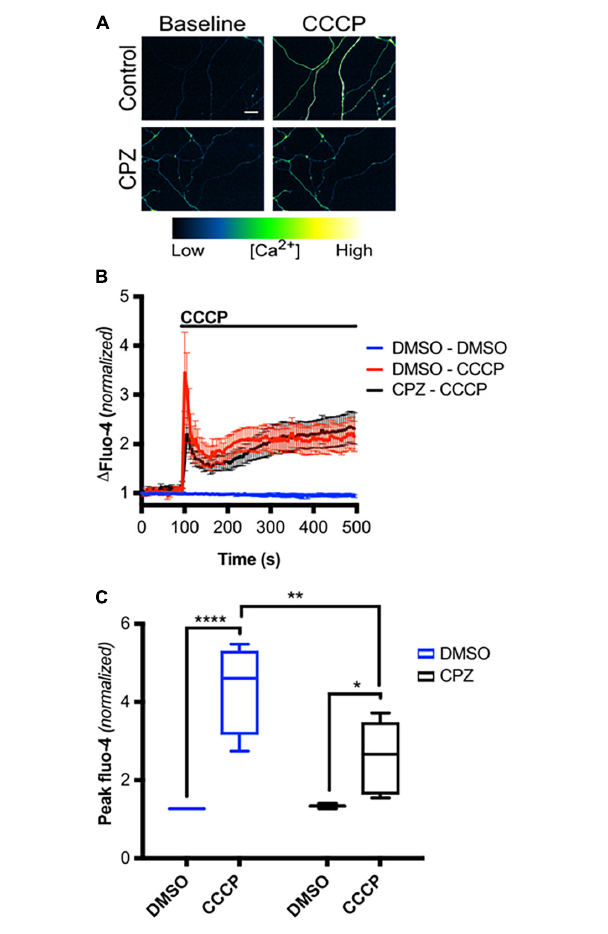
FIGURE 5 | Mitochondrial depolarization in intact axons induces ROS-dependent calcium influx. (A) Micrographs of Fluo-4-AM-loaded axons, treated with Ca 2 + -free media or NAC (20 mM), before and immediately after CCCP treatment (50 µ M) (scale bar indicates 25 µ m). (B) Changes in Fluo-4 intensity before and after CCCP treatment, normalized to intensities at t = 0 s [ n = 8 (Ctrl – DMSO, Ctrl – CCCP), 4 (No Ca 2 + – CCCP, NAC – CCCP)]. Values are mean ± SEM. (C) Peak Fluo-4-AM intensities immediately following CCCP treatment (taken from panel B ), normalized to intensity at t = 0 s. Boxplots are minimum, 1st quartile, median, 3rd quartile, maximum. Statistical significance was assessed using a two-factor ANOVA followed by Tukey’s post hoc comparison. ** p < 0.01, **** p < 0.0001.